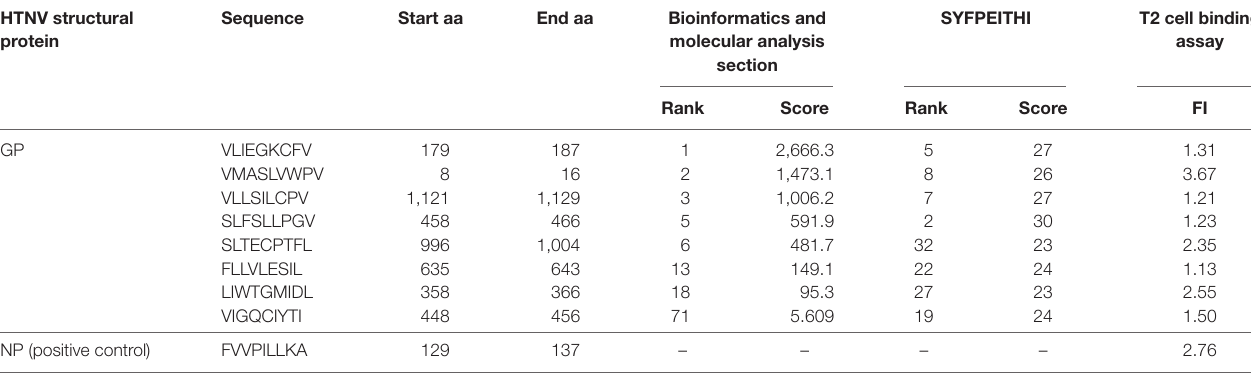
Table 3 | Information for the eight screened Hantaan virus (HTNV) glycoprotein (GP)-derived HLA-A*0201-restricted high-binding affinity nonapeptides by the T2 cell binding assay. hTnV structural sequence protein